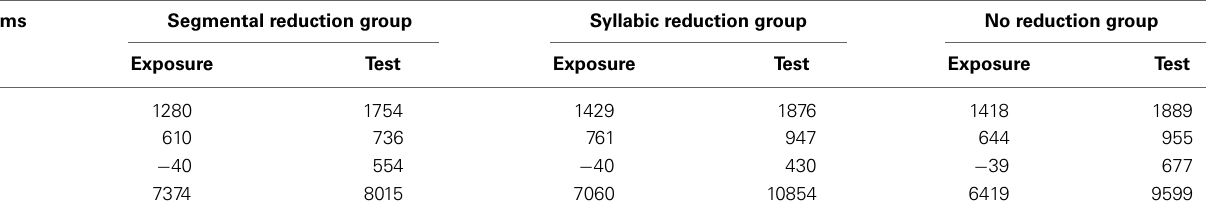
Table 5 | RT in ms in the exposure and test phases of Experiment 3 for clicks on targets and competitors.